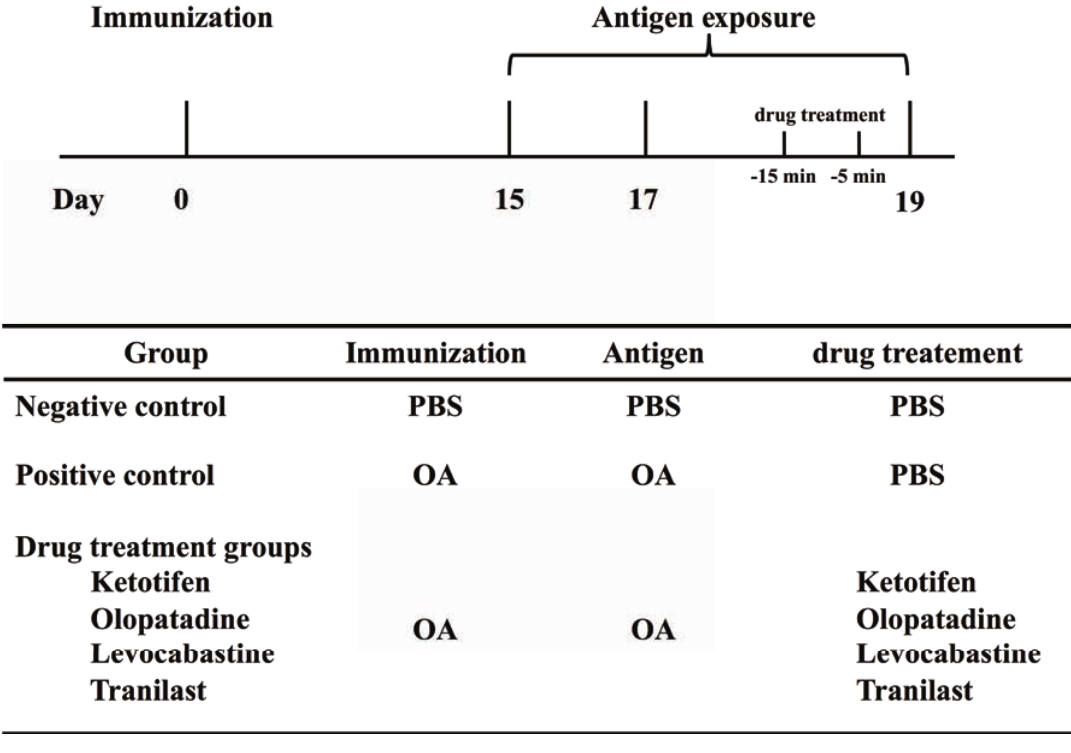
Figure 1: Experimental protocol. On day 0, three-week-old guinea pigs were injected subconjunctivally with 2 μg of OA and 2 mg of aluminum hydroxide gel. On days 15, 17, and 19, AC animals were challenged with OA. On day 19, anti-allergic drug was administered in the drug-treatment groups, and PBS was used in the AC positive control group at 5 and 15 min before OA